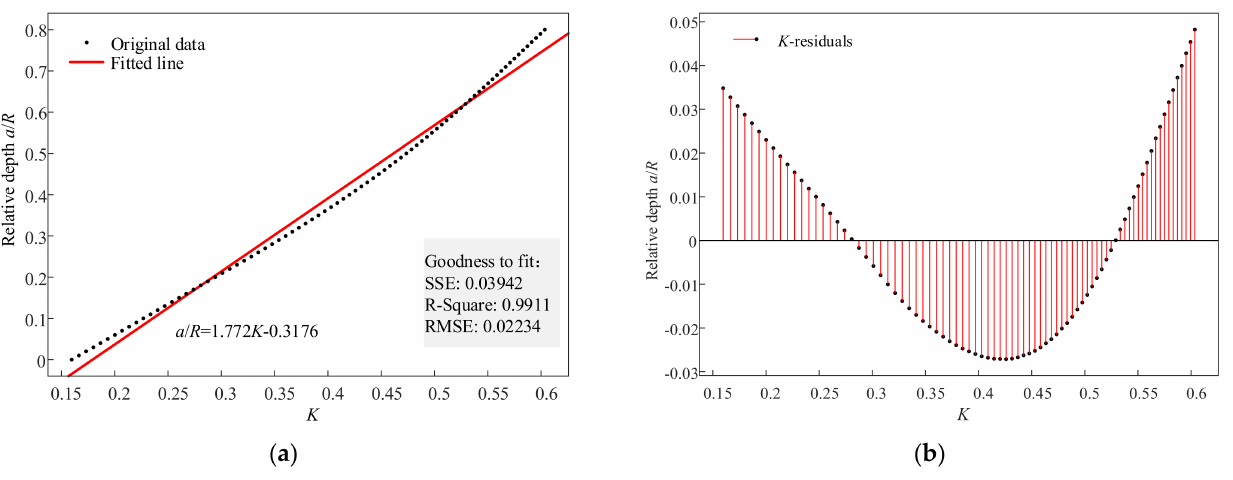
Figure 9. The fitting results of K : ( a ) fitted line and ( b ) residuals